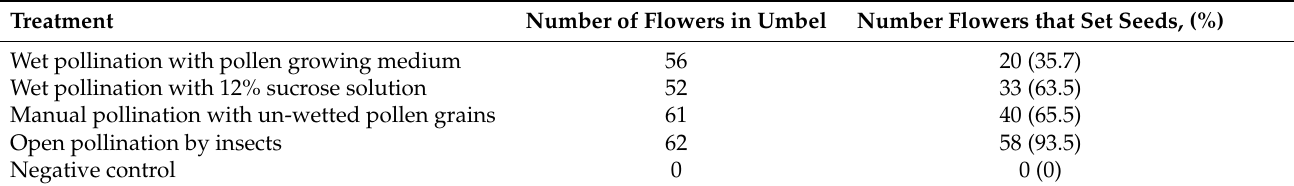
Table 1. The effect of different pollination methods on seed setting in the A. cepa